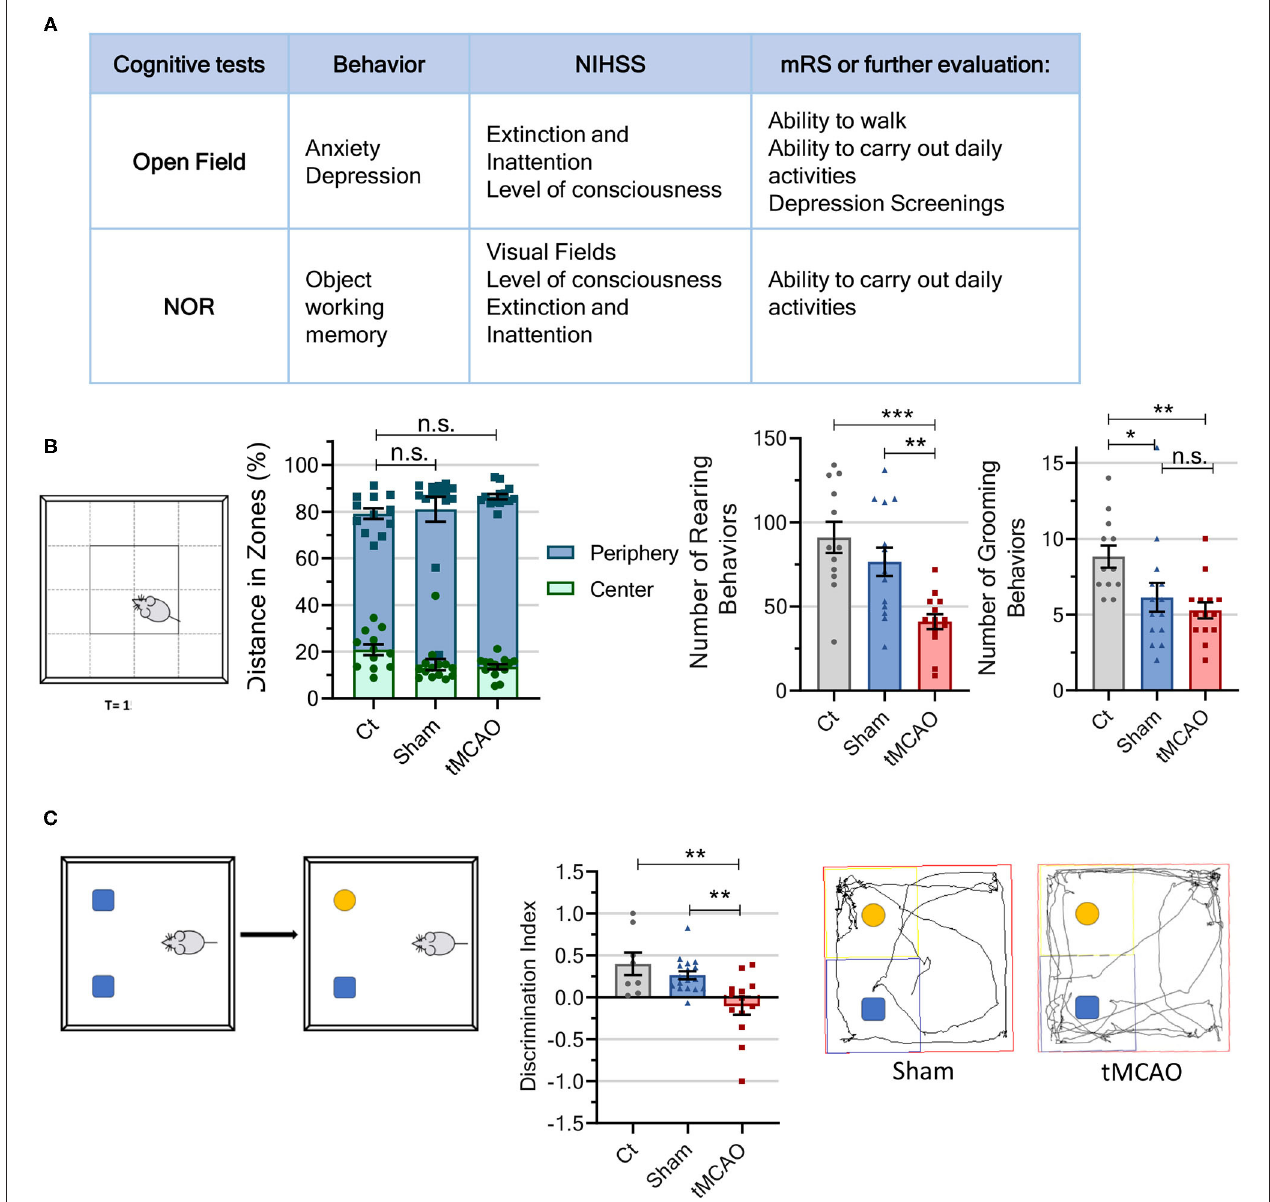
FIGURE 5 | Cognitive tests from the behavioral workflow indicate that subjecting mice to a surgery procedure may increase anxiety-like behaviors and that ischemic lesion leads to memory loss. (A) Table comparing the parameters evaluated in the cognitive tests to the scores assessed in human patients using the mRS and NIHSS. (B) Schematic representation of the open field arena. Besides the previously mentioned motor parameters, the open field also allows for determination of mice’s exploratory behavior. When the mice move more along the arena walls (percent of distance traveled in each arena zone, center and periphery) and perform fewer grooming behaviors, it points to increased anxiety, while lack of rearing behaviors points to lack of exploration [CT n = 12 (8 males and 4 females), sham n = 14 (5 males and 9 females), tMCAO n = 14 (9 males and 5 females); statistical meaning for both periphery and center]. (C) Schematic representation of the novel object recognition test and representative tracing of gait pattern from the tMCAO and sham animals. The NOR test allows for evaluation of memory, since the animals demonstrate memory deficits when they spend the same amount of time exploring the novel and familiar objects, as well as a negative mean discrimination index (time spent exploring novel/familial objects ratio) [CT n = 8 (4 males and 4 females), sham n = 17 (4 males and 13 females), tMCAO n = 13 (5 males and 8 females)]. **** p < 0.0001, *** p < 0.001, ** p < 0.01, * p < 0.05. One-way ANOVA followed by Tukey’s multiple comparison